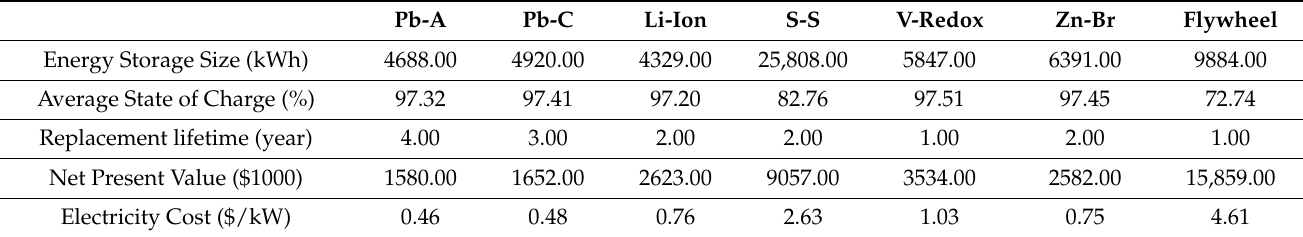
Table 3. Electric power production cost for various energy storage technologies . Pb-A